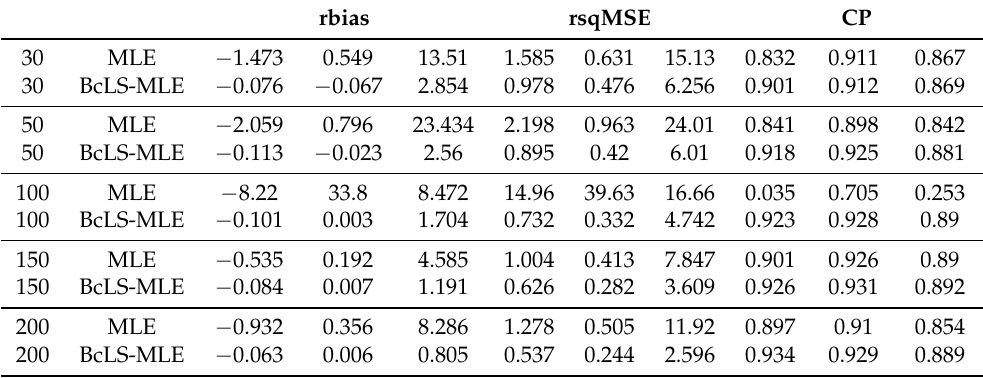
Table 10. The rbias and rsqMSEs of the BcLS-MLE and MLE, and the CP of S ( y 0 | Θ ) for LPN ( Θ ) with ξ = 5, σ = 3, γ = 3, and 1 − α =